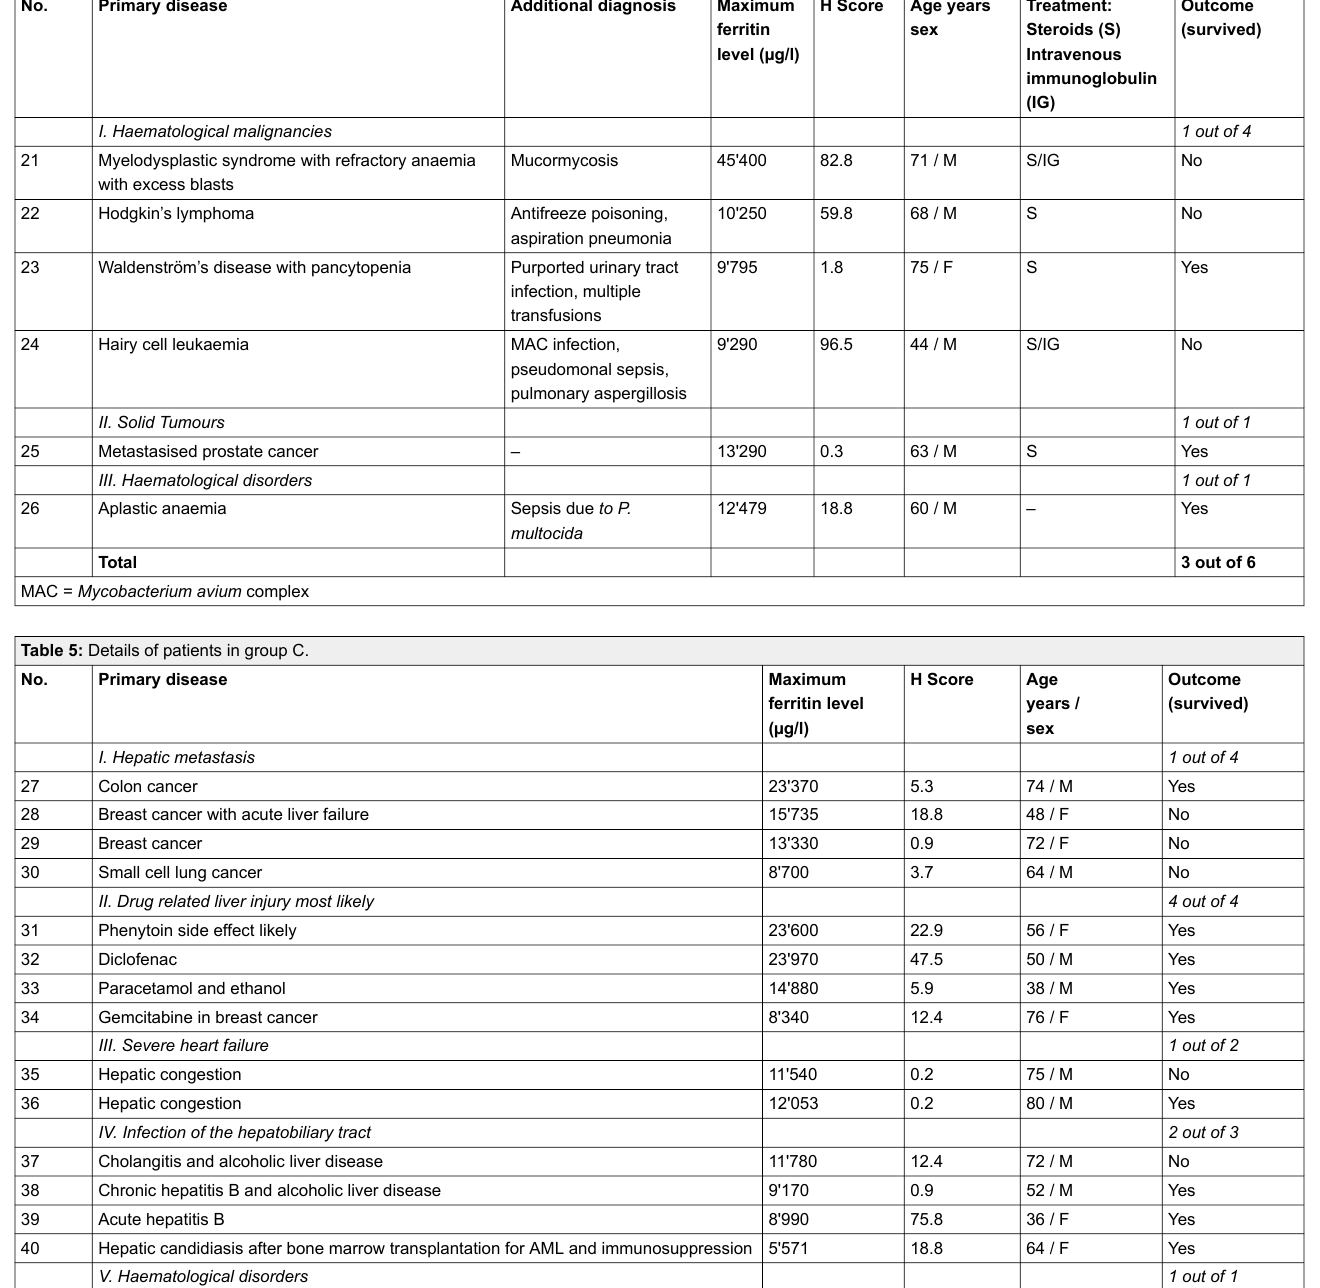
Table 4: Details of patients in group B.